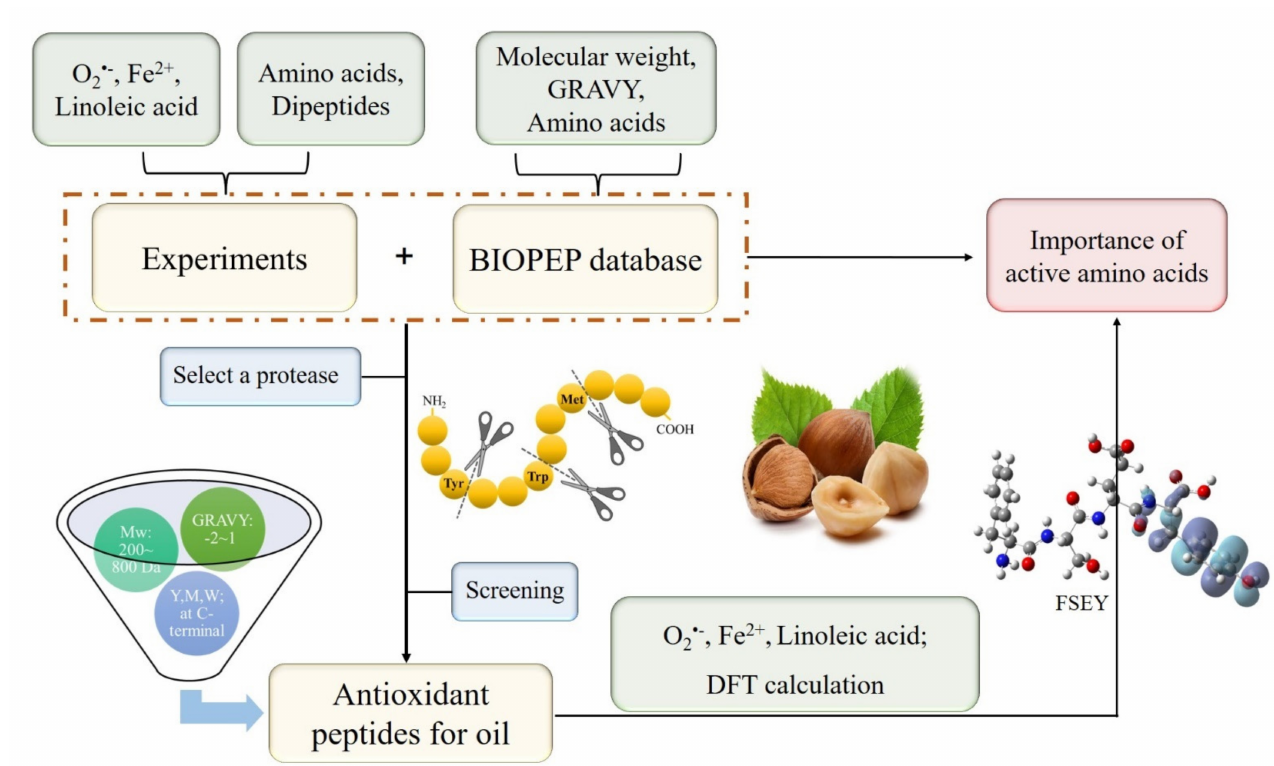
Figure 5. Screening antioxidant peptides depending on properties of amino acid